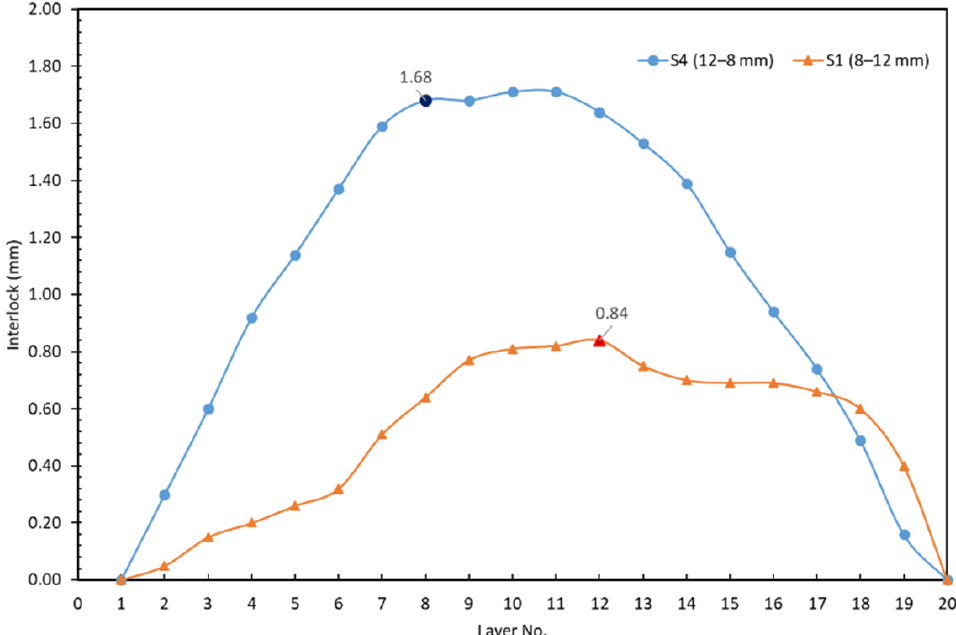
Figure 9. Comparison of interlock for experiments S4 (12–8 mm) and S1 (8–12 mm). The numbers refer to the thickness of the top and bottom sheets, respectively. The emphasized markers show the interfaces. Layers are numbered from the bottom.